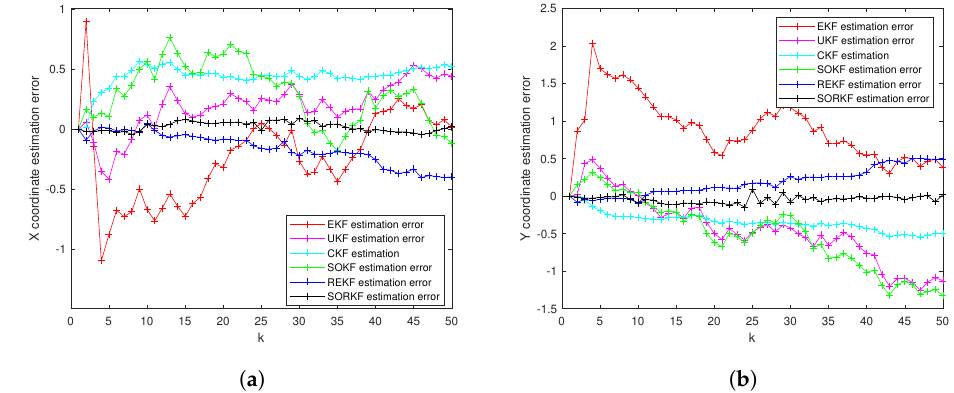
Figure 14. R2 estimation error of multi-robot swarm in random topology formation. ( a ) X-Coordinate estimation error; ( b ) Y-Coordinate estimation